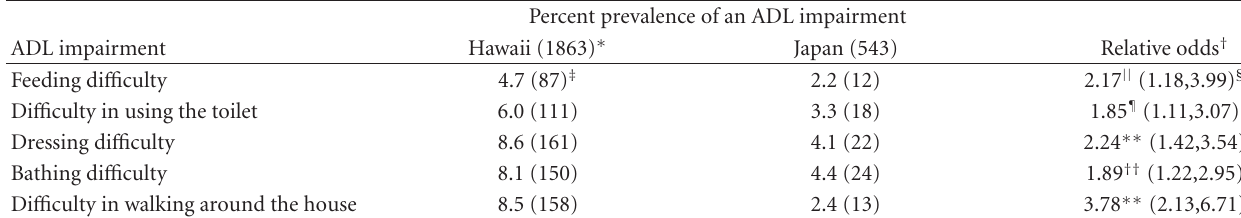
Table 1: Percent of elderly men with an impairment in activities of daily living (ADL) in Hawaii and Japan.